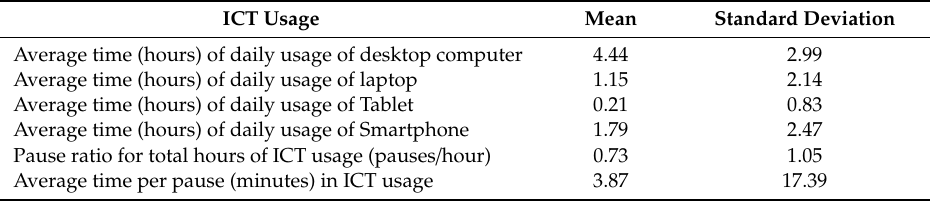
Table 2. Descriptive results (1): Centrality and deviation indicators of ICT Usage.